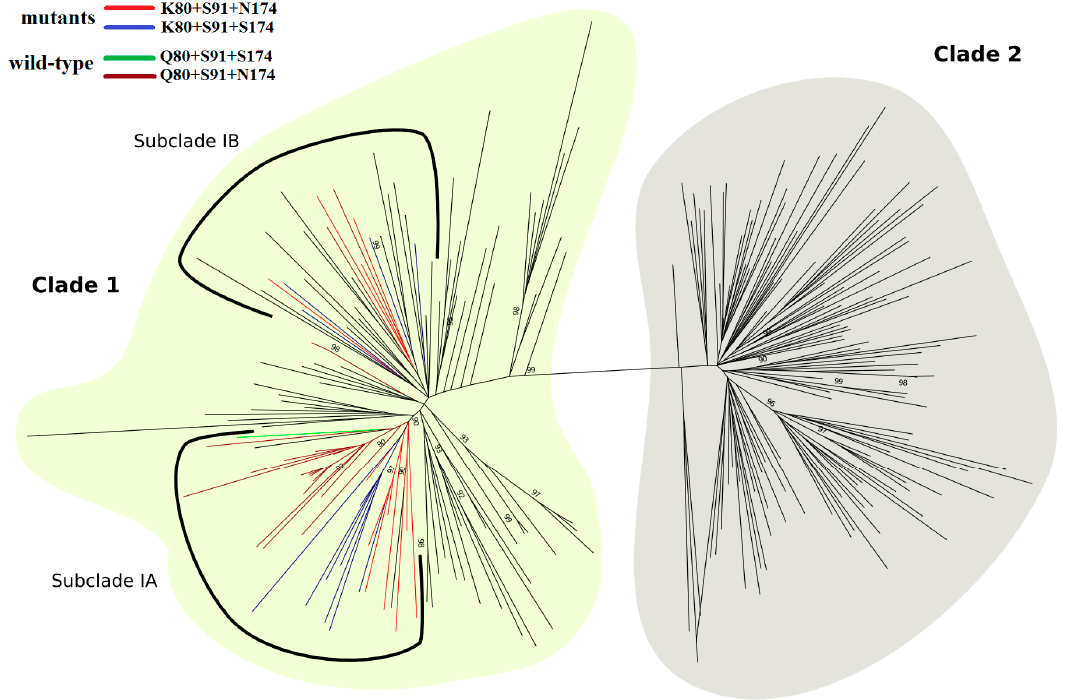
Figure 8. ML phylogenetic tree of HCV-1a based on 120 representative sequences of each, clade I (light yellow) and clade II (gray). Within clade I, subclade IA and subclade IB are highlighted by a solid black line. A total of 12 K80 + S91 + N174 (red) and 12 K80 + S91 + S174 (blue) polymorphic sequences are grouped in the two subclades, whereas most of the 19 wild-type sequences (brown and green) cluster into a single branch, formed by 16 sequences. In clade I, branches colored in black are represented by sequences containing K80 ( n = 48), Q80 ( n = 25), G80 ( n = 1), L80 ( n = 1), N80 ( n = 1), and R80 ( n = 1). In clade II, black branches represent sequences containing Q80 ( n = 117), R80 ( n = 2), and L80 ( n = 1). The tree was rooted with HCV-1b strain (D90208). Approximate likelihood-ratio test values ≥ 0.90 are shown. For better visualization, sequence names were